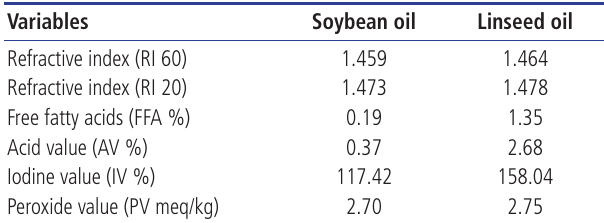
Table 2. Chemical analysis of soybean oil and linseed oil Variables